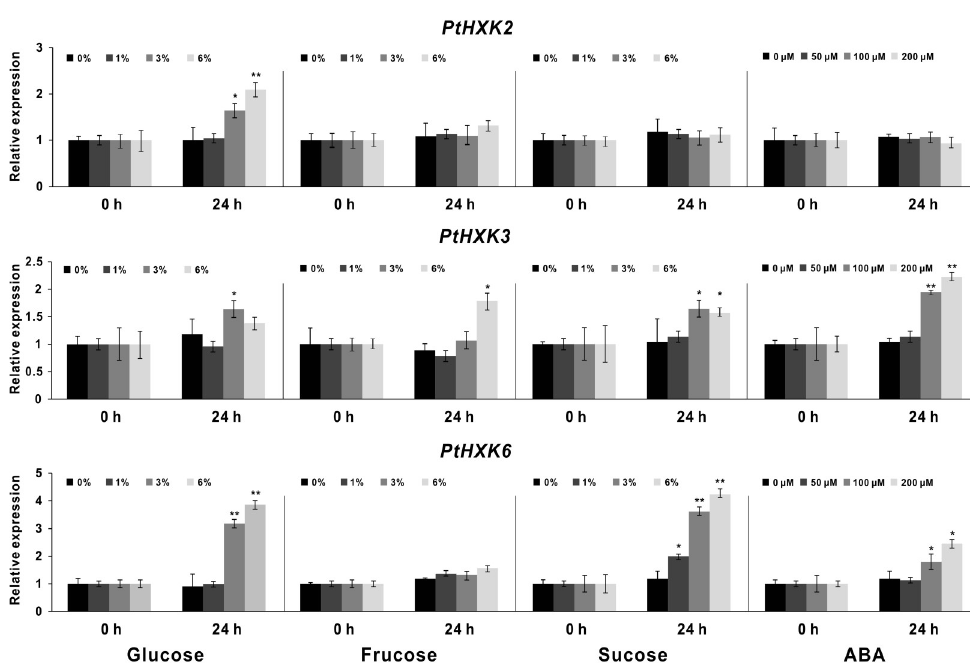
Figure 6. Expression effects of three PtHXKs in the roots feeding with various sugars and ABA. The qRT-PCR analyses show the transcript responsiveness upon the altered concentration of sugars (glucose, fructose, and sucrose) and ABA. The relative expression of the control was set as 1. Data represent mean values ±SE of at least three independent biological replicates. PtβActin , PtUBIC , and PtEF-α1 were used as reference genes. Asterisks indicate significant differences in comparison with the control using the Student’s t -test: ** p < 0.001, * p < 0.01.